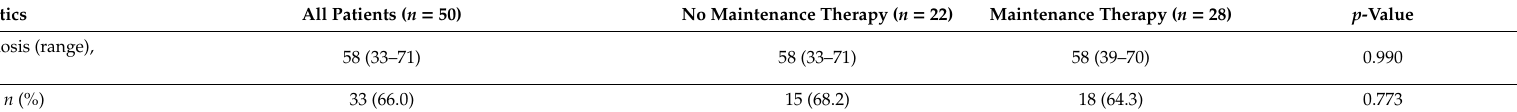
Table 1. Baseline and demographic data of patients at